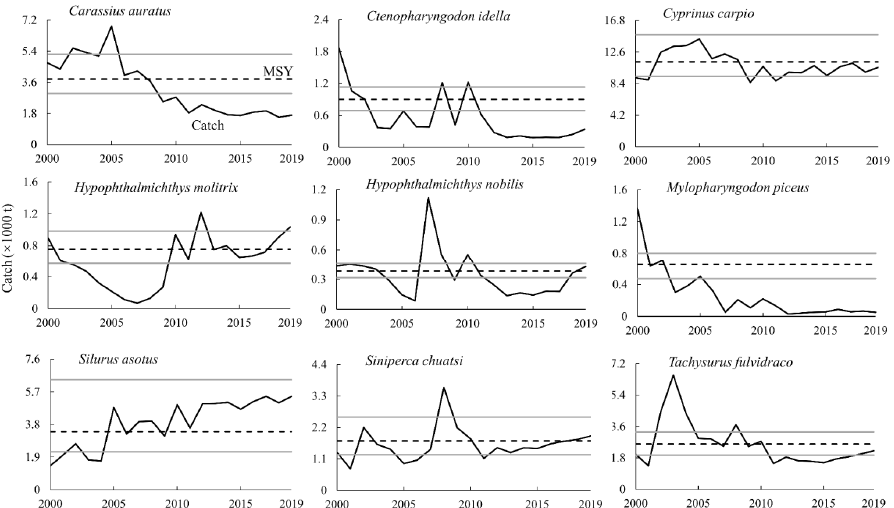
Figure 2. Catches (solid black lines) of nine main economic fishes from 2000 to 2019 and their values of MSY. Black dotted lines indicate mean values of MSY, and solid gray lines represent a 95% confidence interval.